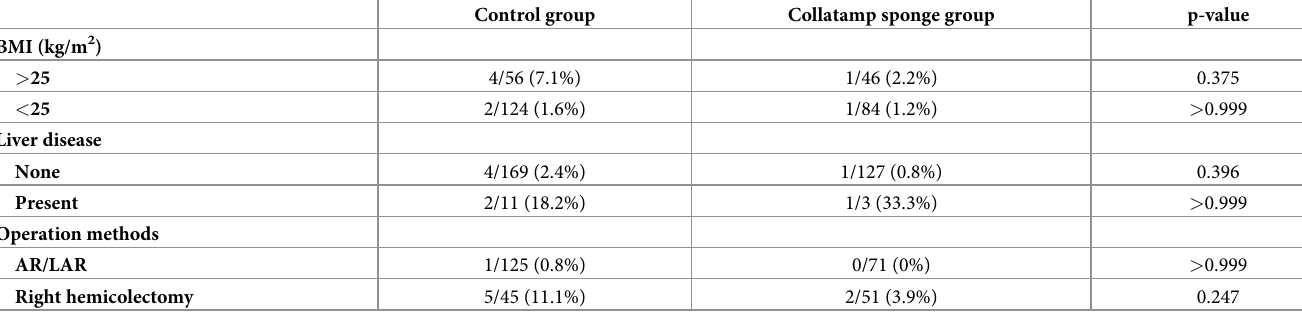
Table 5. Subgroup analysis of surgical site infection in high-risk